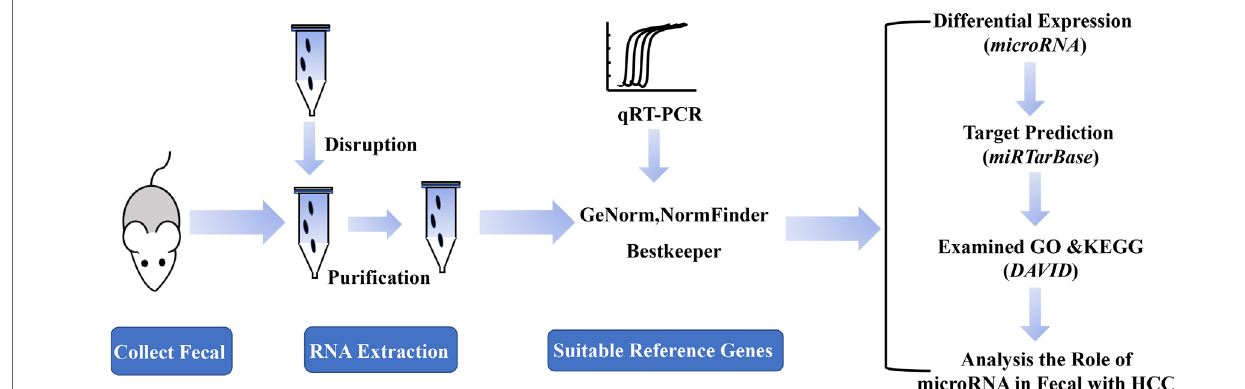
FIGURE 1 | A schematic diagram of the experimental